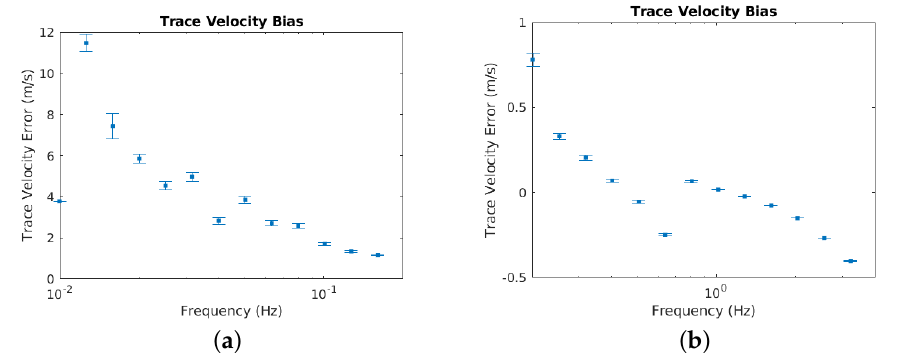
Figure 13. Trace velocity error (bias) due to filtering in TDOA. The error bars represent the standard deviation of the trace velocity errors. ( a ) Frequency lower than 0.2 Hz. ( b ) Frequency higher than 0.2 Hz.